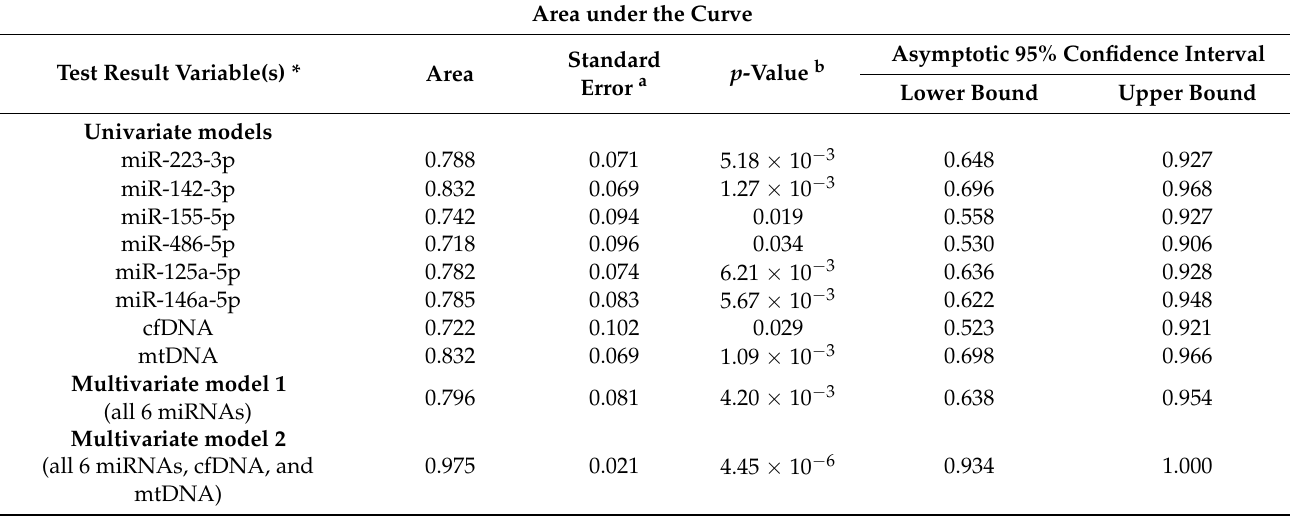
Table 3. Receiver operating characteristic (ROC) analysis for predictive potentials of univariate and multivariate models for follow-up major adverse cardiovascular events (MACE), using plasma miRNA, total cell-free DNA (cfDNA), and cell-free mitochondrial DNA (mtDNA) values measured at hospital discharge (T 1 ) in ST-elevation myocardial infarction (STEMI) patients. Area under the